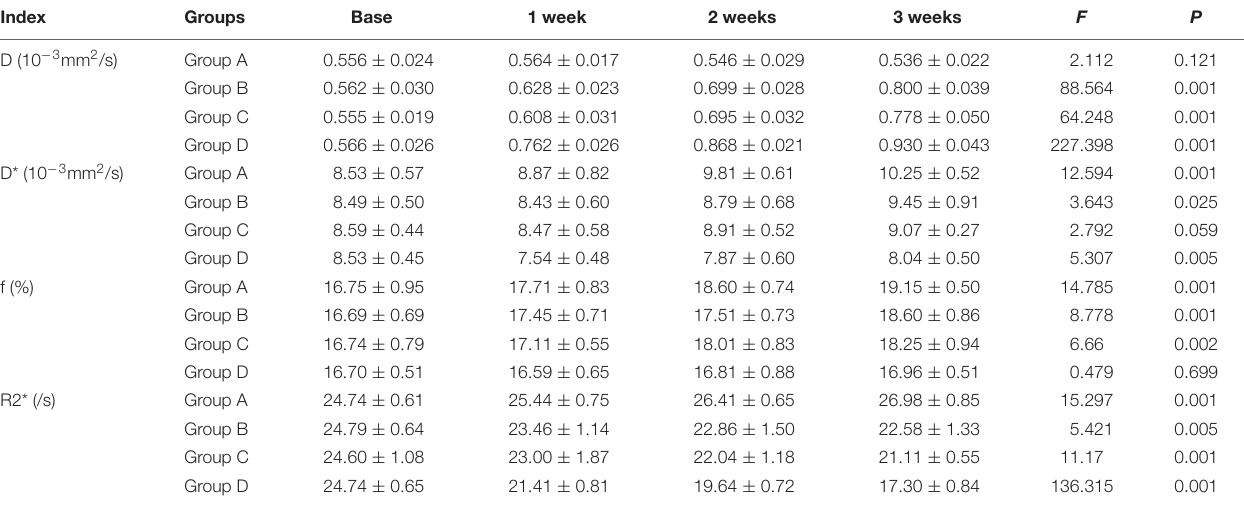
Repeated measures analysis of variance was used generate the P-value.